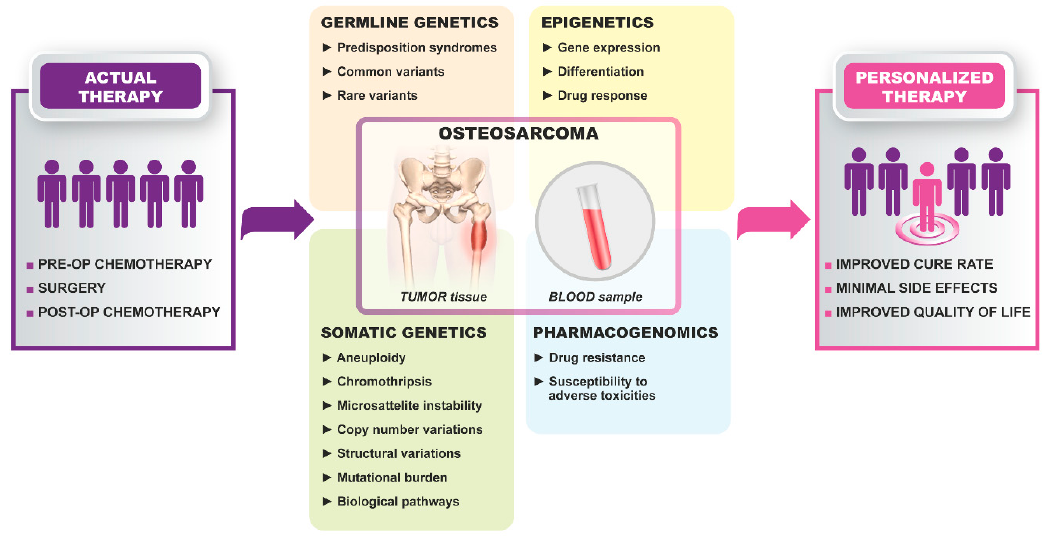
Figure 1. Transition toward personalized therapies in high-grade osteosarcoma.